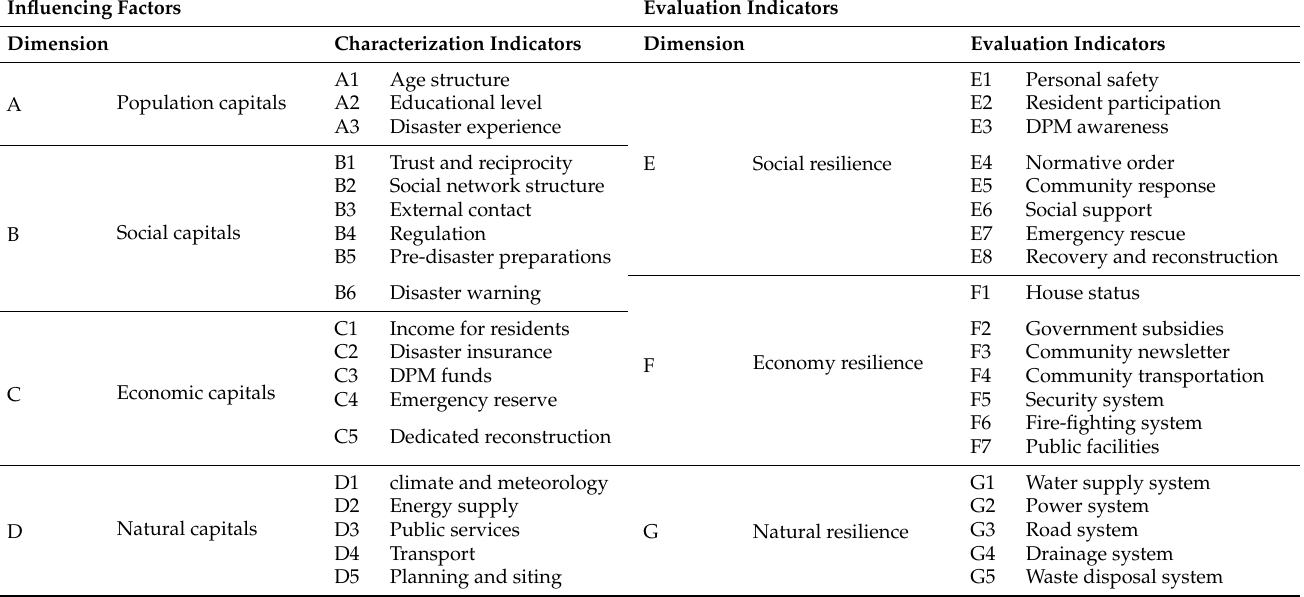
Table 3. Evaluation indicators and influencing factors of the waterlogging resilience in China’s urban